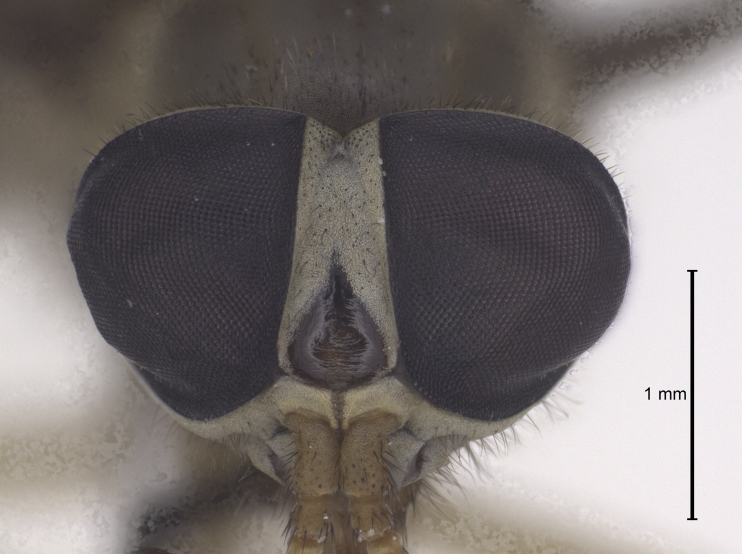
Head, frontal view.